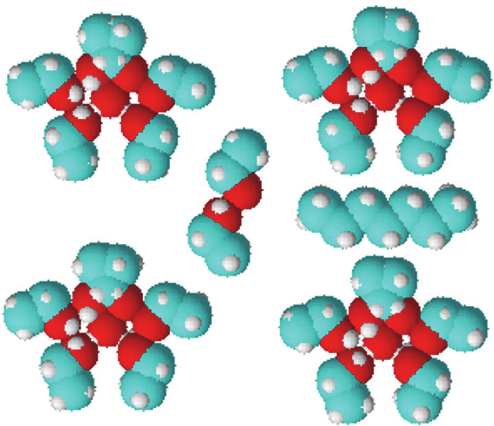
Figure 10: The molecular structure of ethanol 95.5% v being added with 8% v n-heptane.